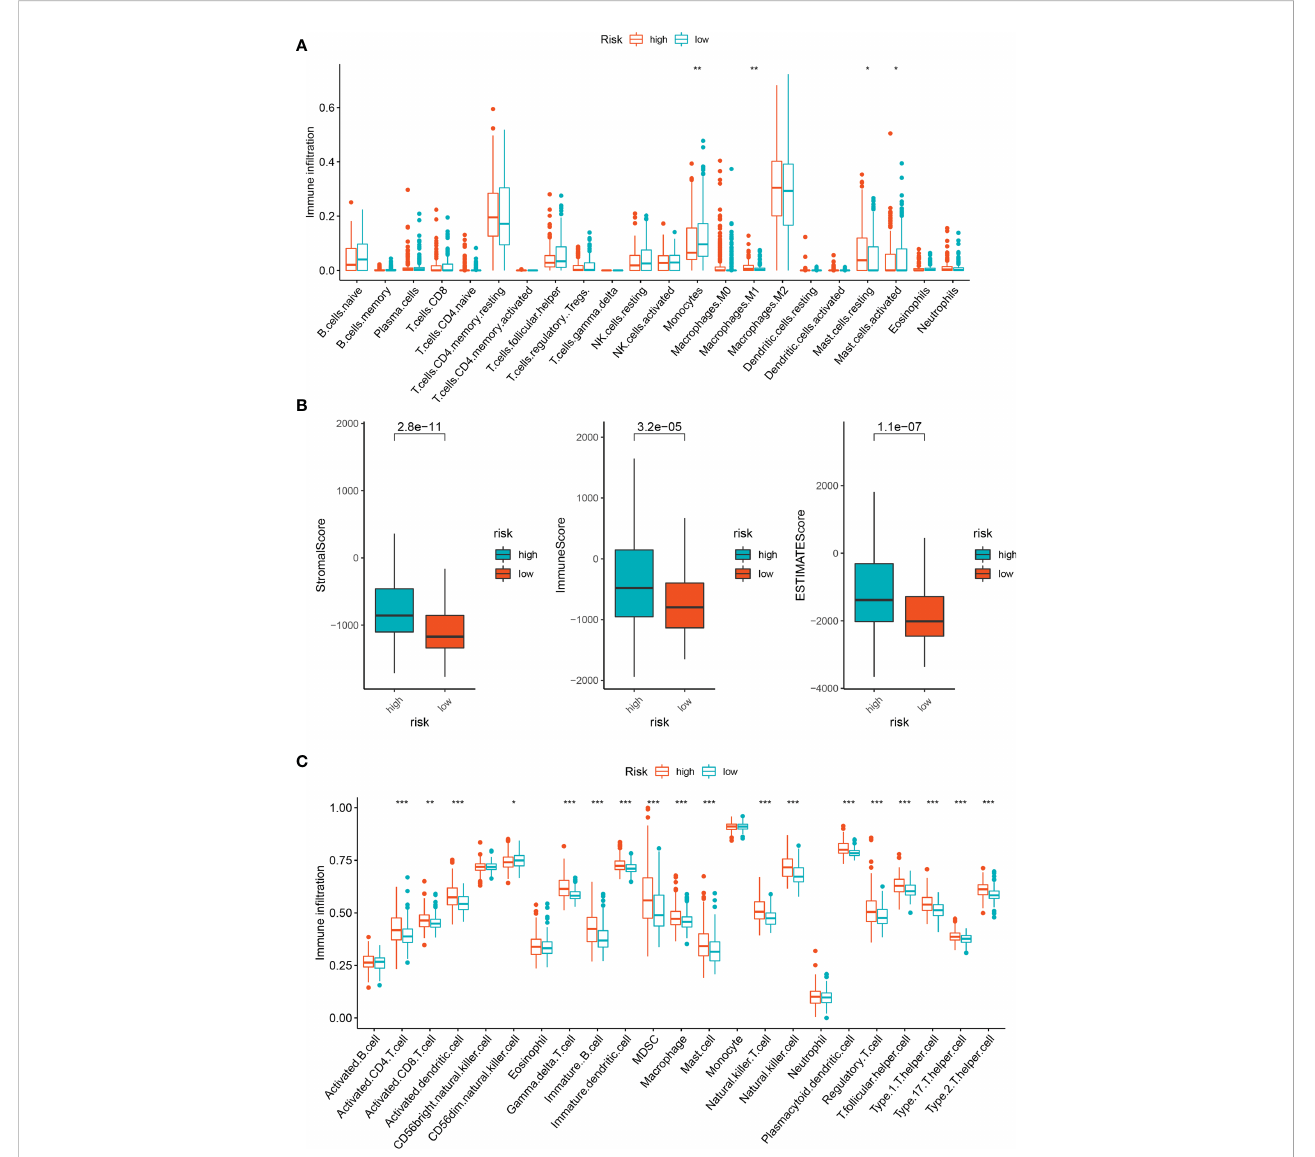
FIGURE 6 Immune in fi ltration analysis of DEGs. (A) Immune cell subpopulations in ssGSEA. (B) Different socres in high- and low-risk group. (C) Immune cell subpopulations in CIBERSORT. *p < 0.05, **p < 0.01, and ***p < 0.001.